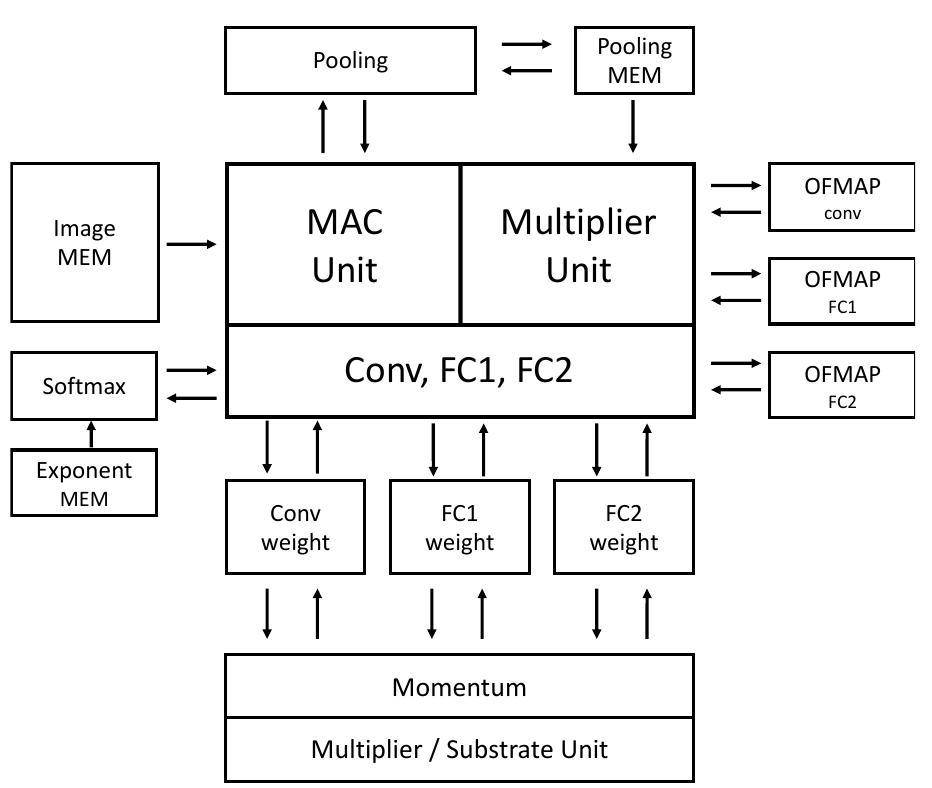
Figure 13. Hardware resource sharing by various layers in the neural network. MAC: multiplication and accumulate.